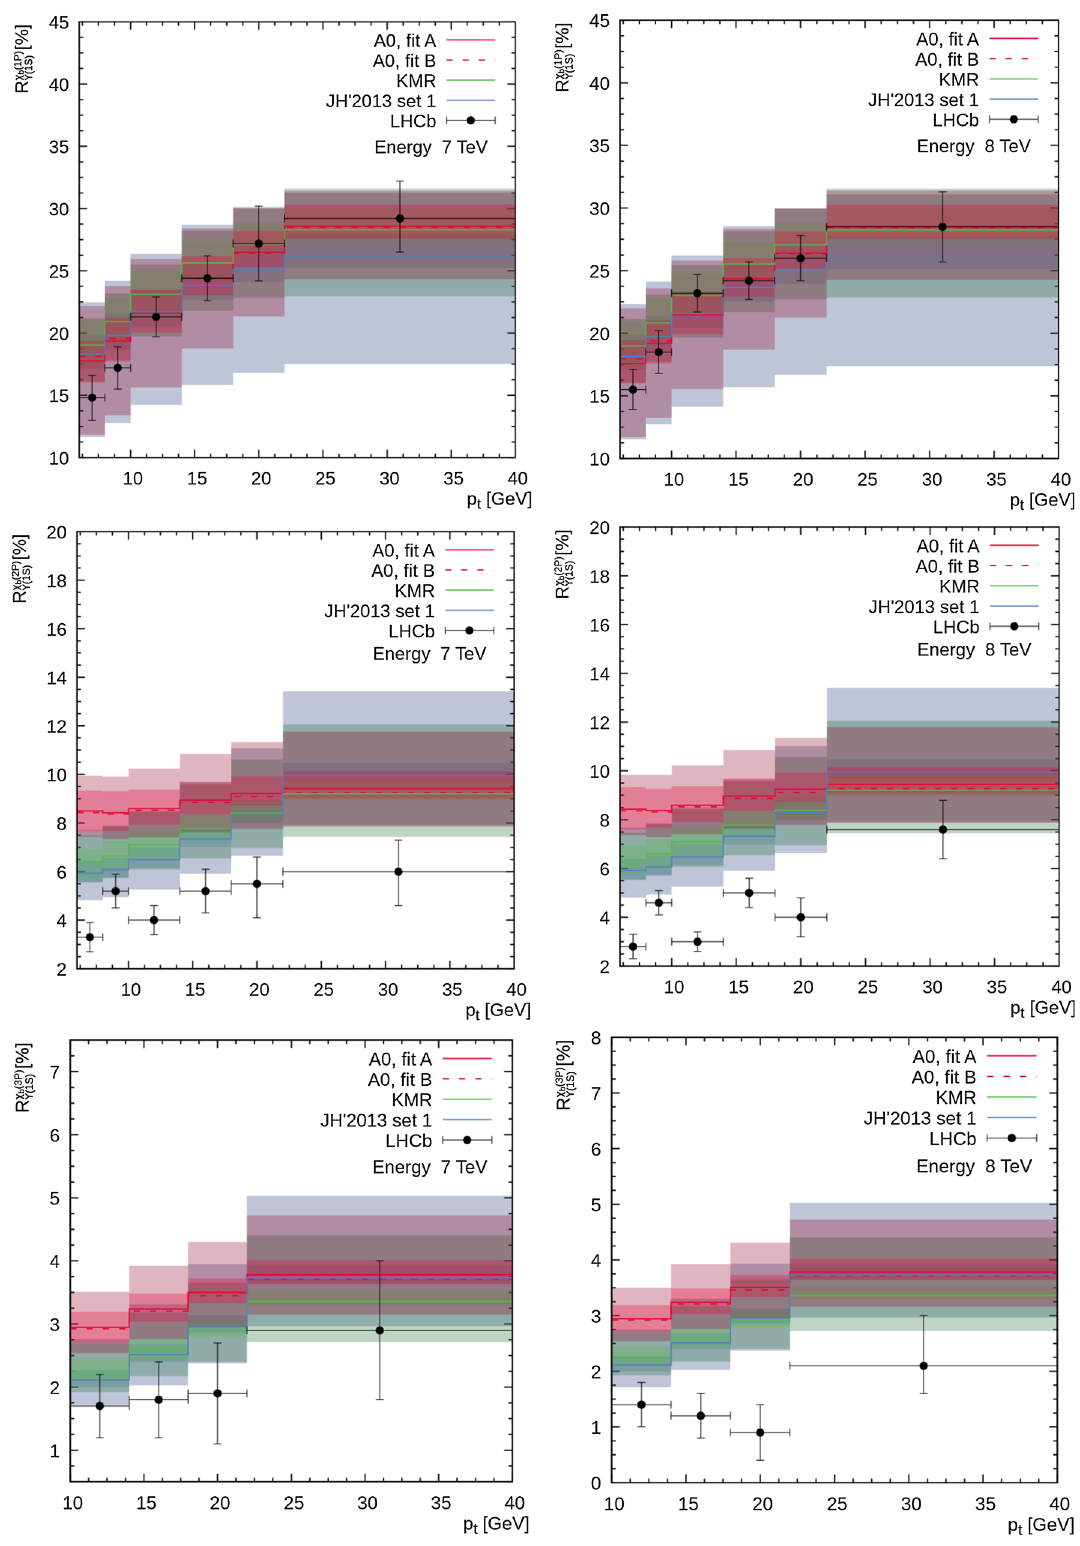
√ s = 7 and 8 TeV using the NMEs from